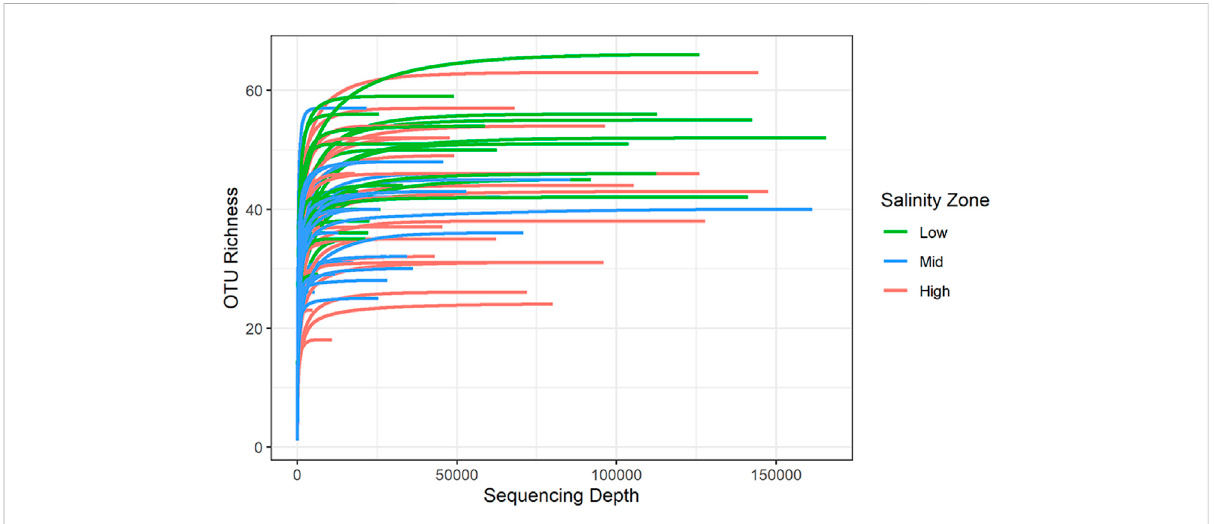
FIGURE 1 Alpha rarefaction curves show the number of OTUs detected in each sample when randomly sampling sequences at each given sequencing